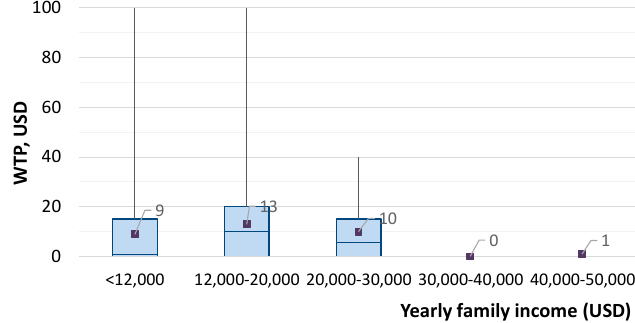
Figure 8. Box-plots for the correlation between WTP and the annual family income level of the respondents (the bullets represent the average value for each category).